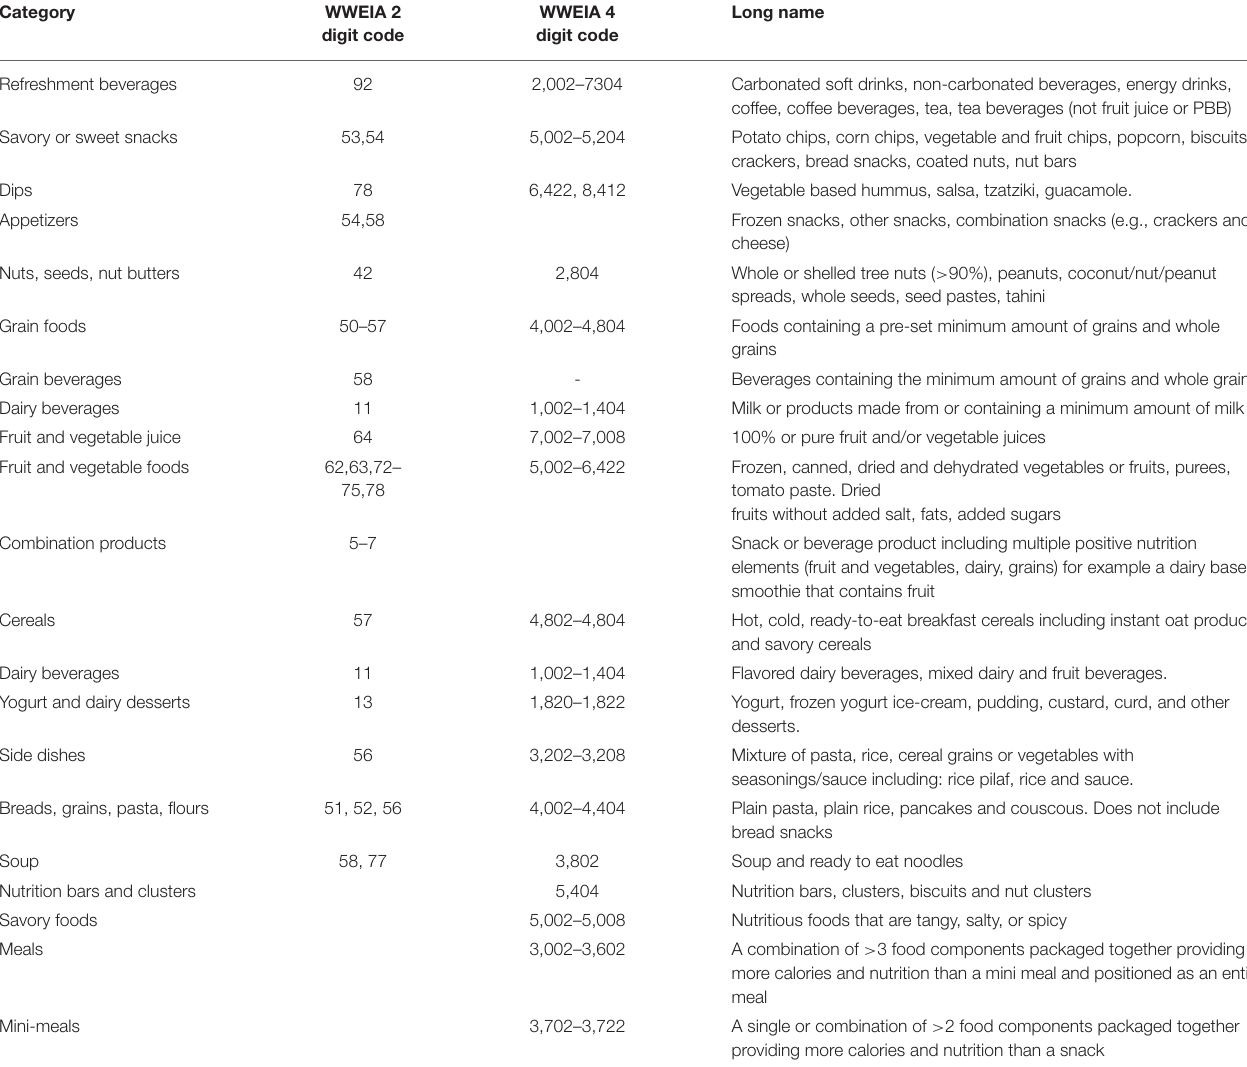
TABLE 3 | Definitions of product categories based on what we eat in America category